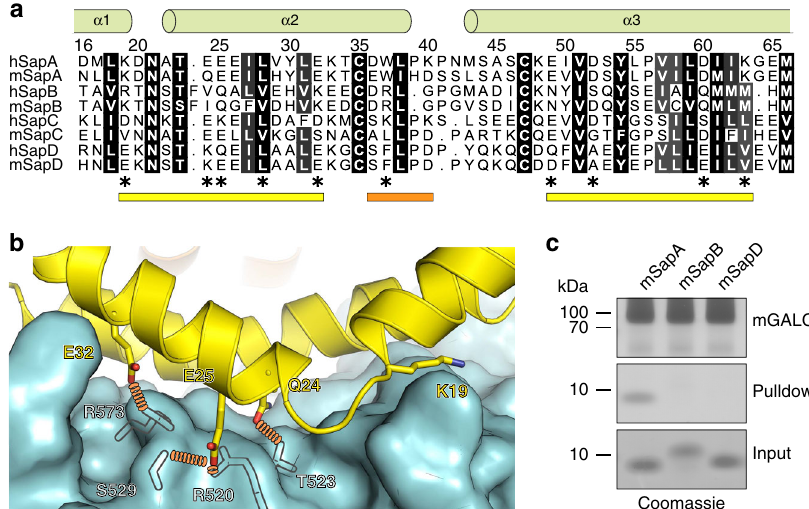
Fig. 5 Saposin speci fi city. a Sequence alignment of human and murine saposins A – D coloured by conservation. Important residues at the GALC – SapA interface are highlighted ( * ). Coloured bars below the sequence identify the regions that interact with GALC: two regions from SapA chain 1 (yellow) and the one from SapA chain 2 (orange) as detailed in Fig. 4a. The position of α -helices in SapA are highlighted (green cylinders). b Critical residues that may determine binding speci fi city are shown (sticks) on SapA (yellow) at the interface with GALC (cyan surface, key residues depicted as transparent sticks). Hydrogen bonds between GALC and SapA residues are highlighted (orange dotted lines). c Coomassie-stained SDS-PAGE pulldowns with immobilised murine GALC (mGALC) illustrating speci fi c binding of murine SapA (mSapA), but not mSapB or